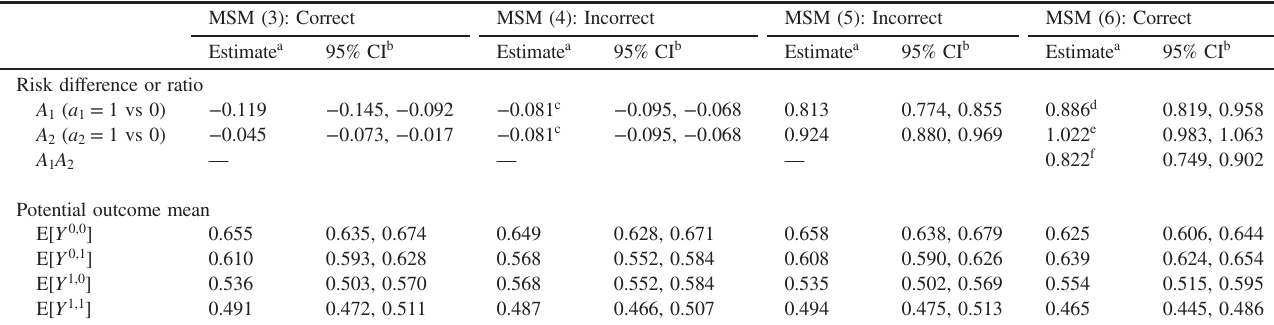
Table 6. Inverse probability weighted estimates of marginal structural models using a misspeci fi ed exposure probability model MSM (3): Correct MSM (4): Incorrect MSM (5): Incorrect